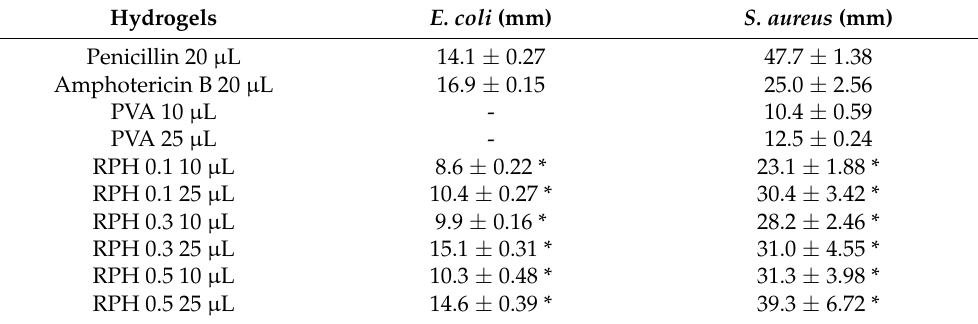
Table 2. Antimicrobial activity of retinol-loaded PVA hydrogel by disk diffusion